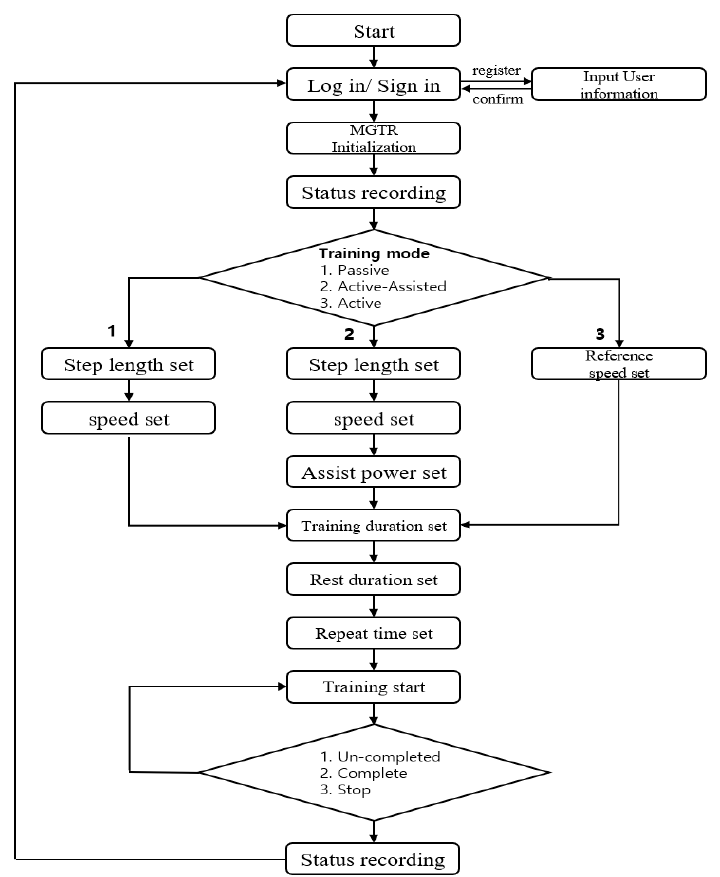
Figure 6. MGTR training program.